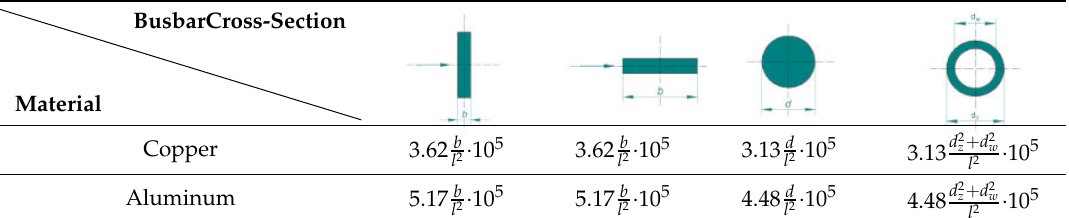
Table 1. Formulas for determining the frequency of natural vibrations concerning the wire shape and